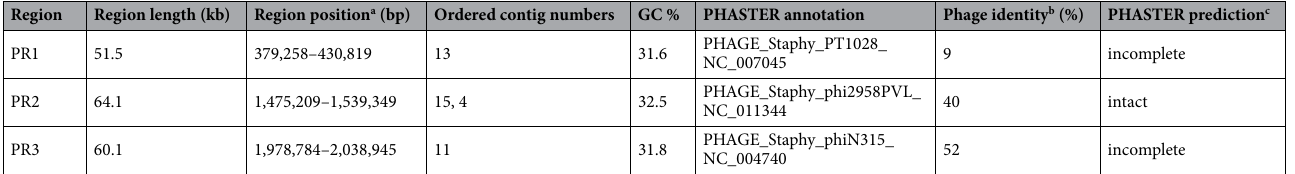
Table 3. Phage-associated regions in the chromosome of the HS-MSSA strain. a Identified prophages were over multiple contigs that were concatenated for PHASTER analysis. b Phage identity was calculated based on the percentage of phage-associated genes over the total protein-coding sequences identified in the phage region. c A prediction of whether the phage region contains genes necessary for lysogeny.